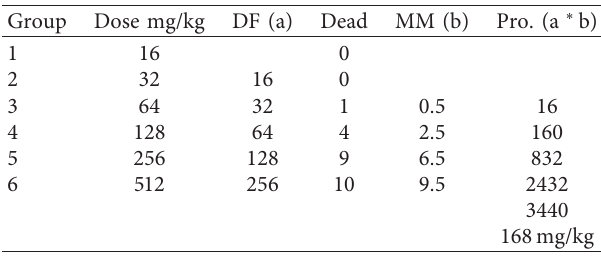
Table 5: LD50 of compound 8 by The Karber